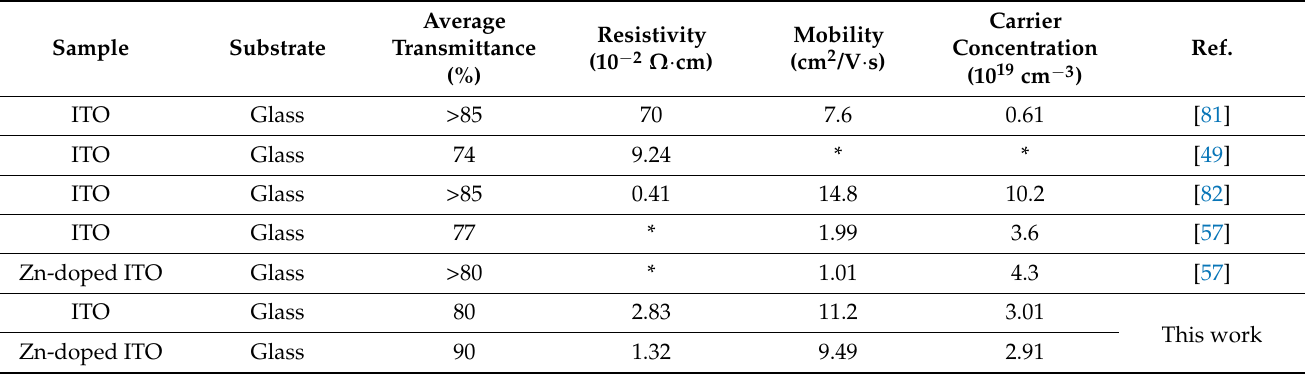
Table 4. Comparison of pure and Zn-doped ITO thin films